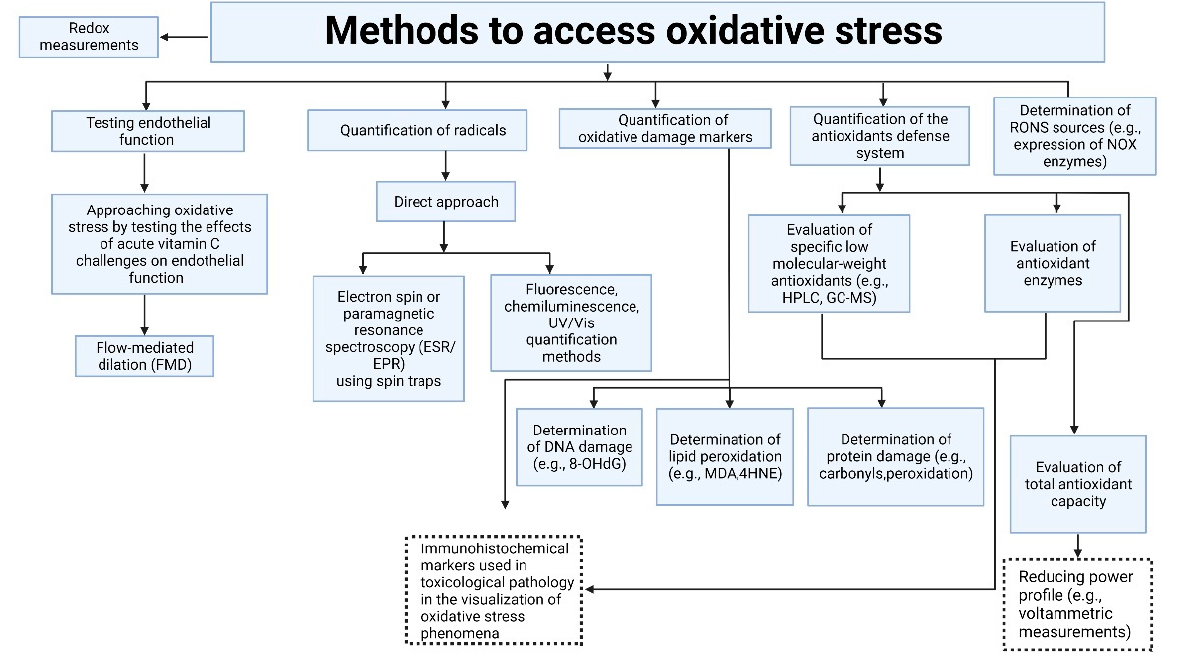
Figure 8. Methods to access oxidative stress . Schematic classification of the methods for determining and quantifying oxidative stress. 4HNE, 4-hydroxynonenal; FMD, flow-mediated dilation; GC-MS, gas chromatography-mass spectrometry; HPLC, high-performance liquid chromatography; MDA, malondialdehyde; NOX, NADPH oxidase; ROS, reactive oxygen species; RNS, reactive nitrogen species; UV, ultraviolet; VIS, visible; 8-OHdG, 8-hydroxydesoxyguanosin. Redrawn and modified from reference [112] with permission (License Number 5484770045925). Copyright © 2002, © SAGE Publications.